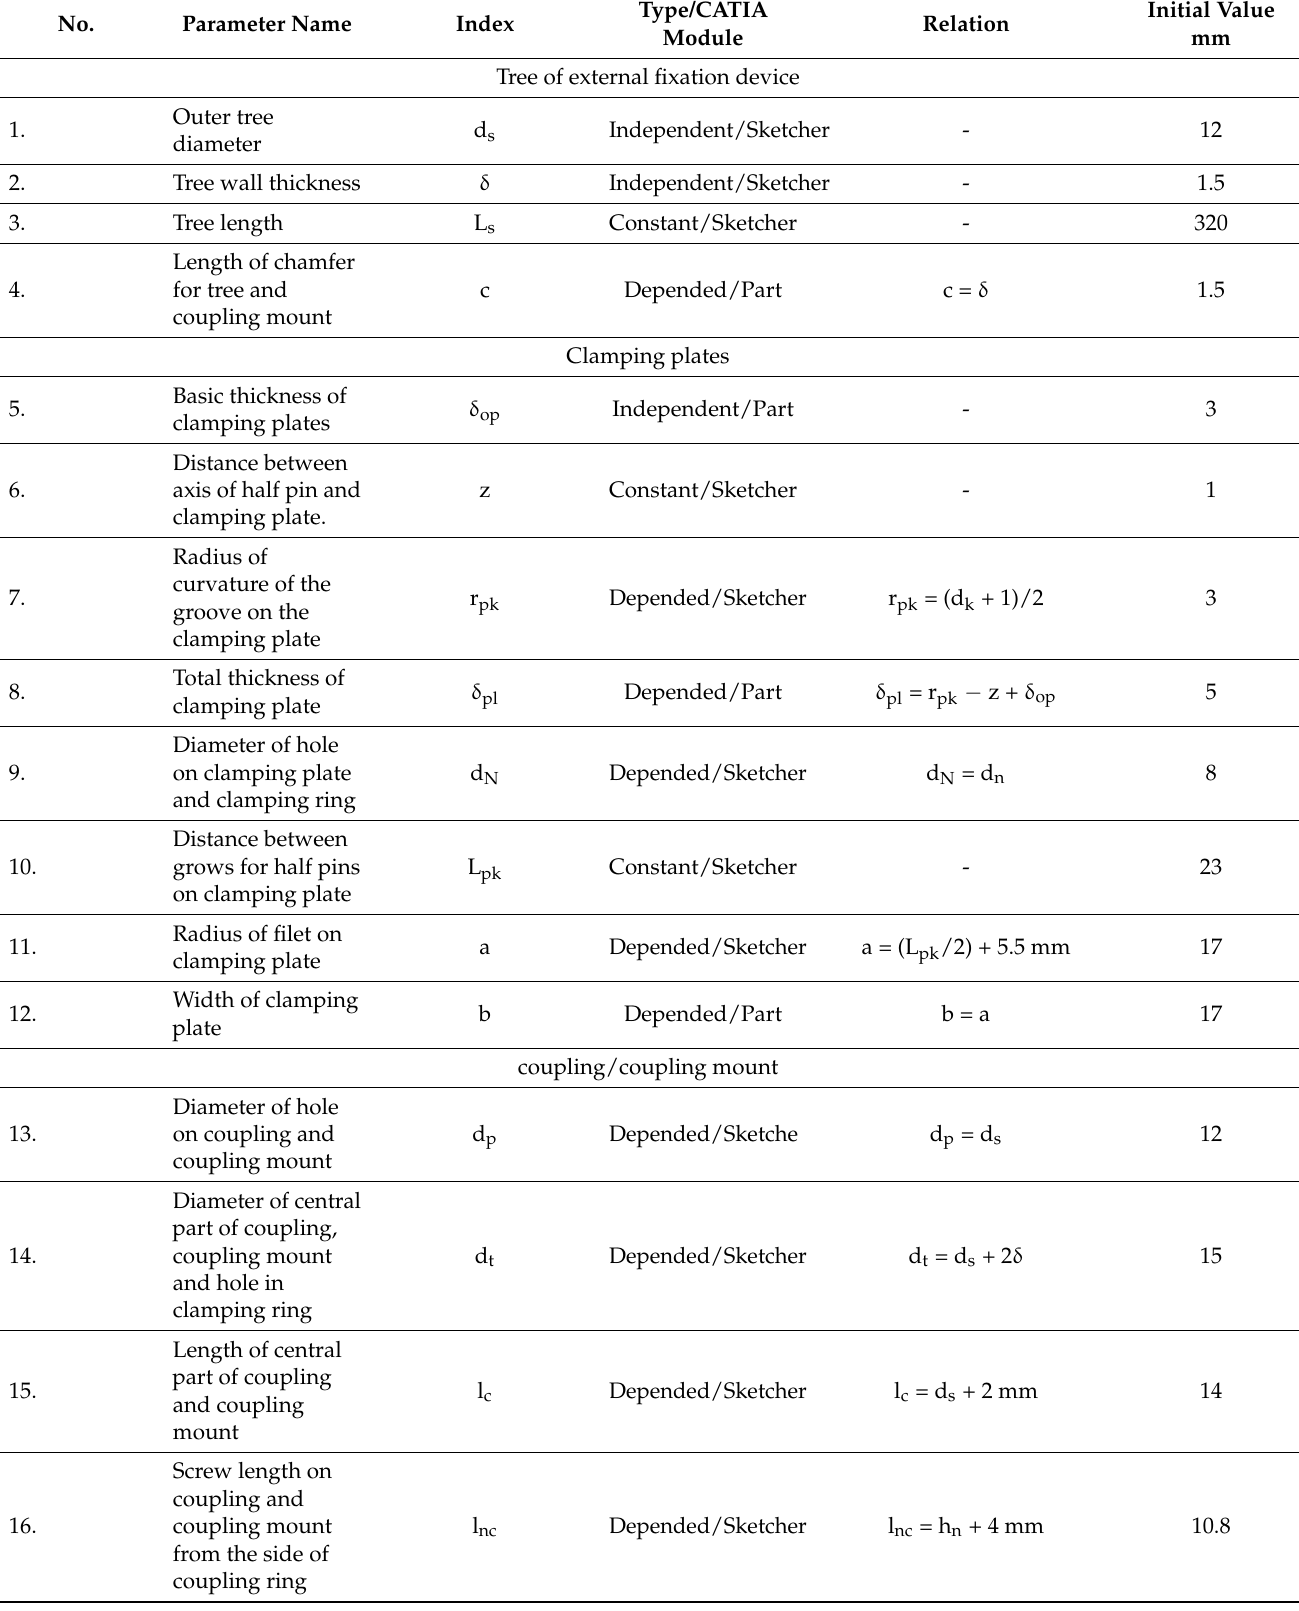
Table 1. External parameters of sub algorithms for components design of external fixation